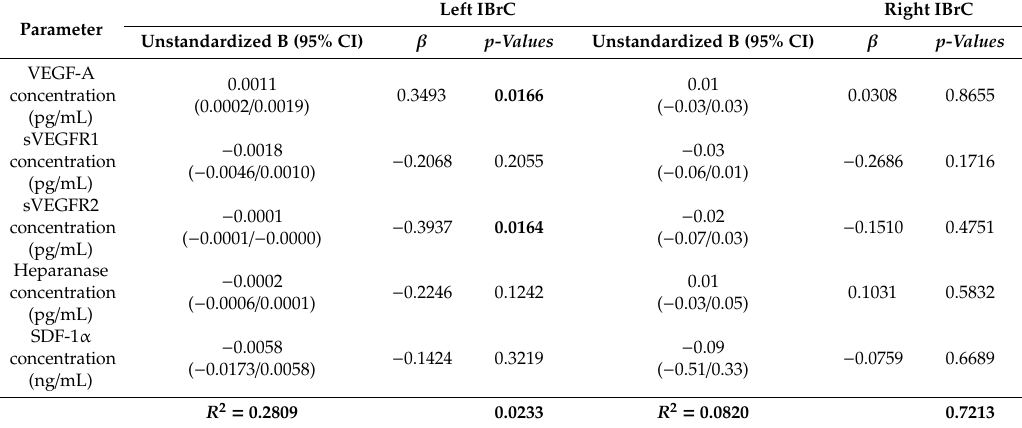
Table 7. Prognostic value of angiogenic parameters with respect to tumor laterality assessed by linear regression.